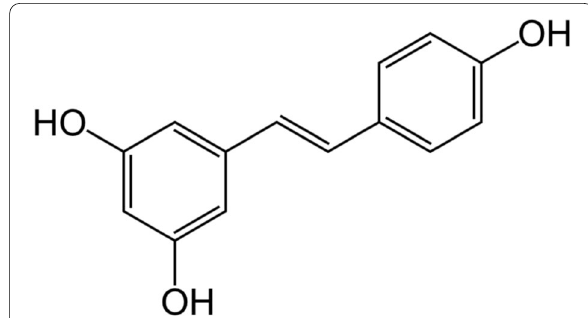
Fig. 1 Resveratrol or 3,5,4 ′